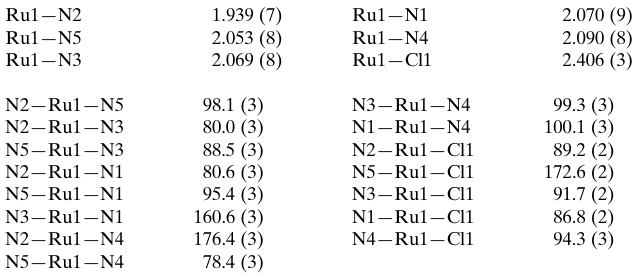
Table 1 Selected geometric parameters (A˚ , (cid:3) ).